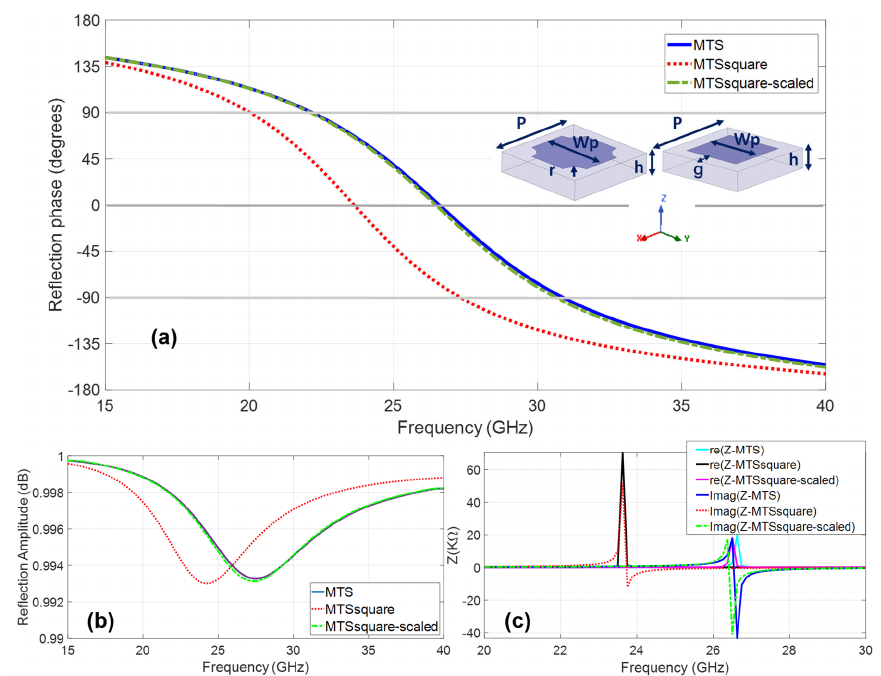
Figure 2. Metasurfaces: ( a ) re fl ection coe ffi cient phase and unit cells dimensions, ( b ) re fl ection coeffi cient amplitude and ( c ) surface impedance.